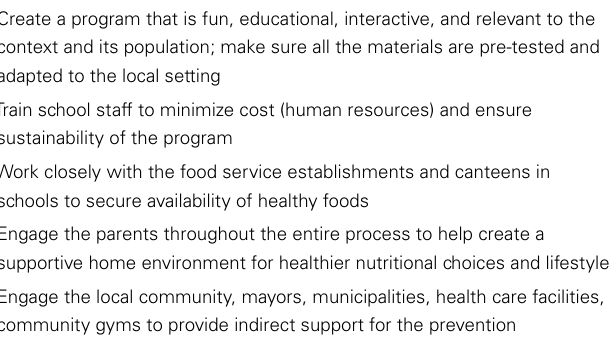
Table 1 | Recommendations for establishing and sustaining a school-based nutritional program .